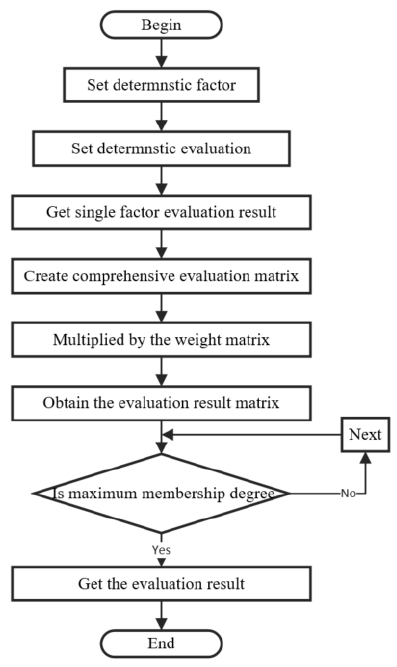
Figure 3. Process of AHP multi-level fuzzy evaluation.